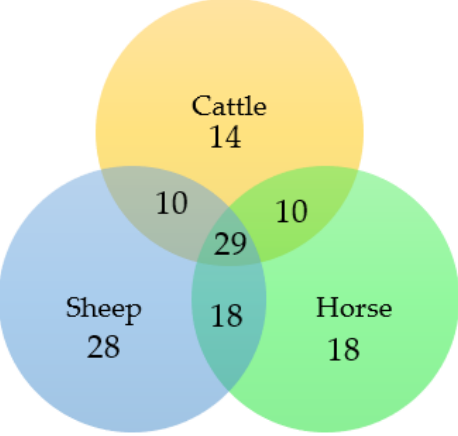
Figure 4. The number of molecular features (metabolites) present in horse, cattle, and sheep dung (based on the Mass Hunter-produced feature list).